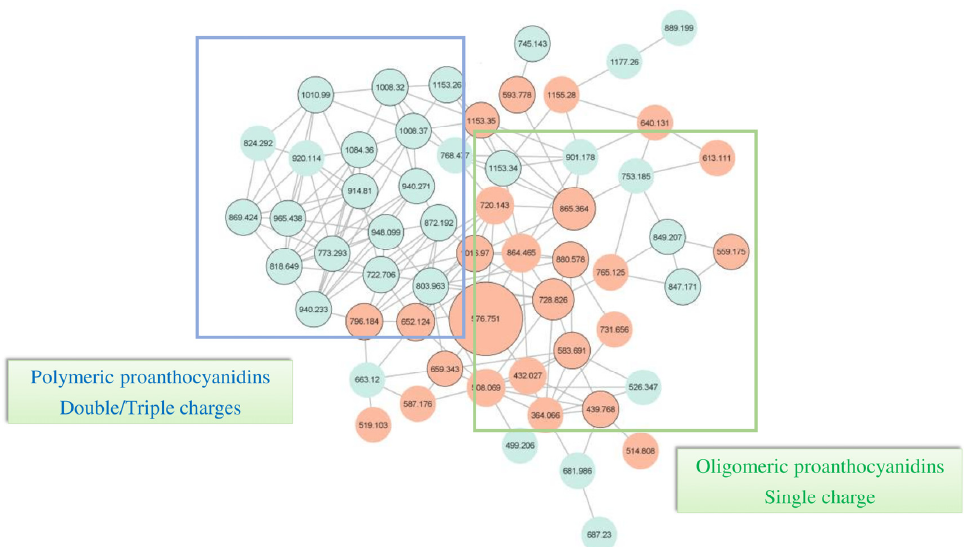
Figure 1. Proanthocyanidin (PAC) cluster obtained by molecular networking (MN) of grape seed extract (GSE) and its alkalinized version (ATGSE). The nodes (circles) represent a consensus MS/MS spectrum having identical precursor mass obtained from the samples, and the colors of the nodes refer to the unique property of the compound present or absent in the two samples. Blue nodes were identified in the GSE extract. Instead, red nodes represent compounds in common in the two extracts. The edges (lines) connect the nodes based on the “cosine score” (fragment match/similarity score ranging from 0.7 to 1), and the thickness of the edges reflects and measures the positive relatedness of the MS/MS spectra of the compounds within a network.